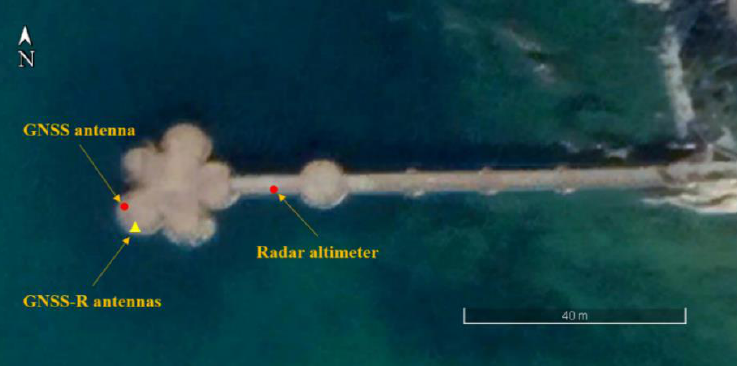
Figure 4. The top view of the experiment. The GNSS-R antennas are mounted on a platform facing south to receive the QZSS GEO signals reflected off the sea surface as shown in Figure 5a. Both the dual-polarized GNSS-R antennas are identical. The operation band of the antenna is from 1.16 to 1.62 GHz. The antenna gain is 5 dBi and the noise figure of the antennae is less than 1.5 dB. The beam angle is ±60°. The down-looking antenna is 30° below the horizontal plane to receive the reflected signal, and the up-looking antenna is positioned symmetrically above the down-looking antenna to receive the direct signals. A recorder is connected to the antennas through RF lines and it digitizes the signals. Further, 2-bit real sampling is adopted. The IF data with the intermedia frequency of 15.58 MHz are sampled at a rate of 62 MHz and collected on a laptop computer. A GNSS receiver and a 26 GHz radar altimeter are placed near the reflector, providing the in-situ SSH during the experiment, as shown in Figures 5b and 6c. The height differences between the various equipment are measured accurately by a Total Station. A software-defined receiver (SDR) is developed to process the IF data. During the experiment, the sea surface is calm and the scatter is coherent. The code delay and phase delay measurements from the QZSS GEO satellite signals are both extracted.